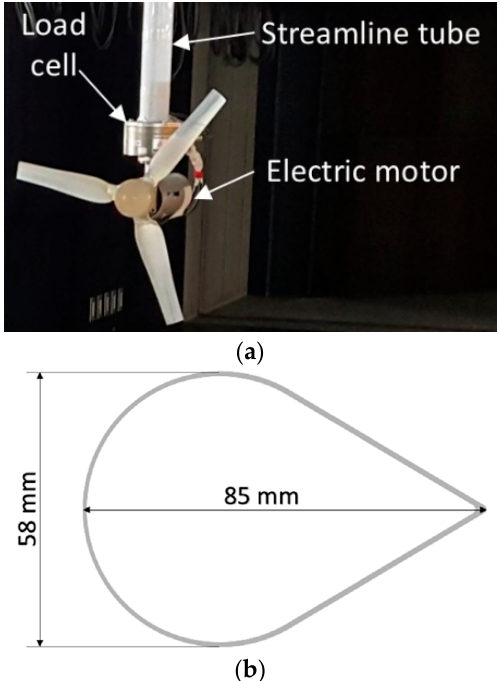
Figure 3. ( a ) Wind turbine model; ( b ) Streamline tube cross section.